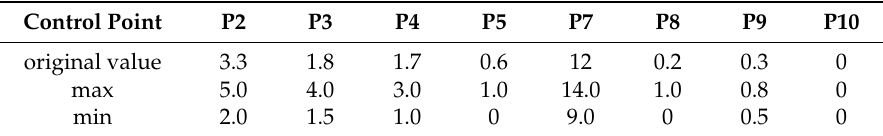
Table 4. Range of design